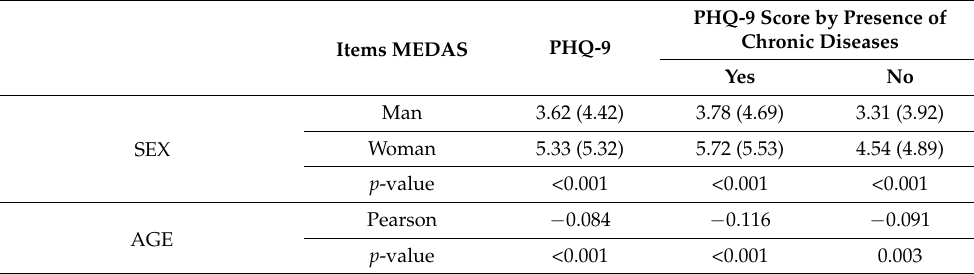
Table 2. Bivariate analysis between sociodemographic variables, MEDAS questionnaire items and depressive symptomatology